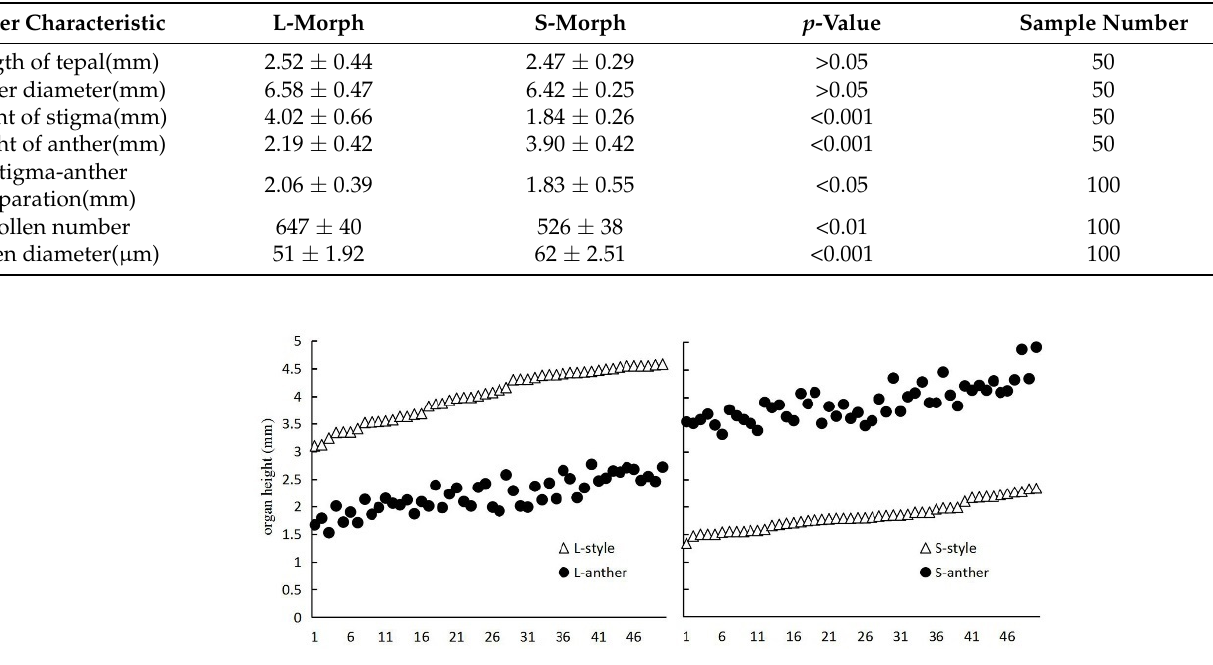
Figure 4. Style and anther length of P.criopolitanum (ranked by style length to illustrate the reciprocal correspondence of stigma and anther positions in the long- and short-styled morphs. Positions of the stigmas and anthers are indicated by open triangle ( △ ) and solid circle ( ● ), respectively).